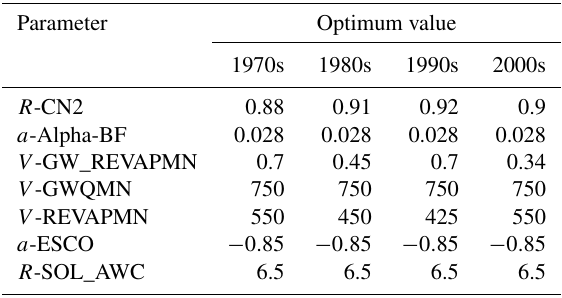
Table 7. SWAT sensitive model parameters and their (final) cali- brated values for the four model